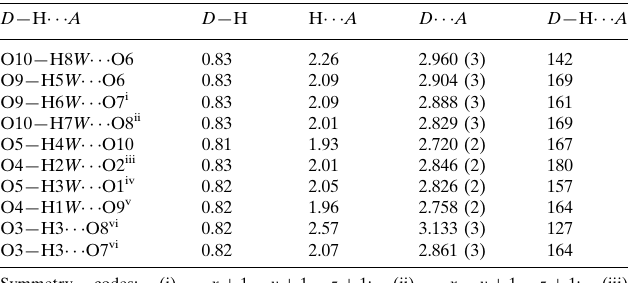
Hydrogen-bond geometry (A˚ , (cid:2)